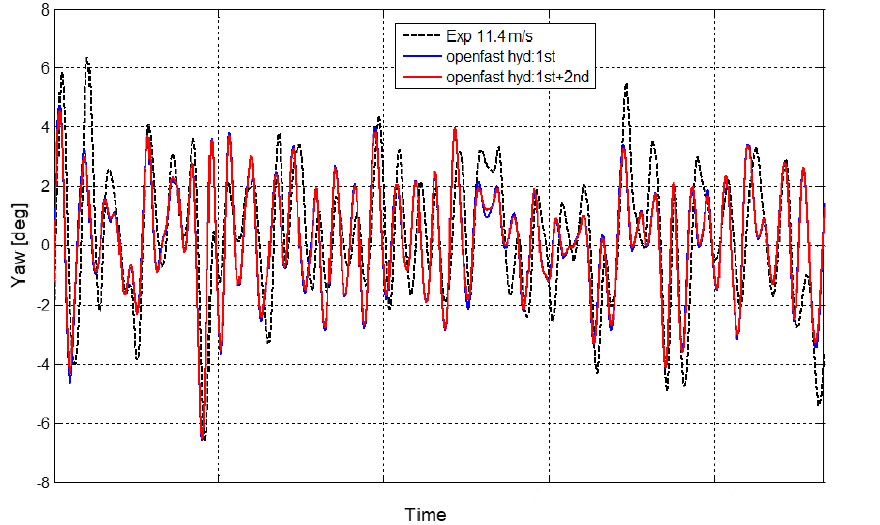
Figure 14. Yaw response of SATH 10MW under turbulent wind with average of 11.4ms − 1 and irregular waves with H s = 3 . 0m and T p = 10 .